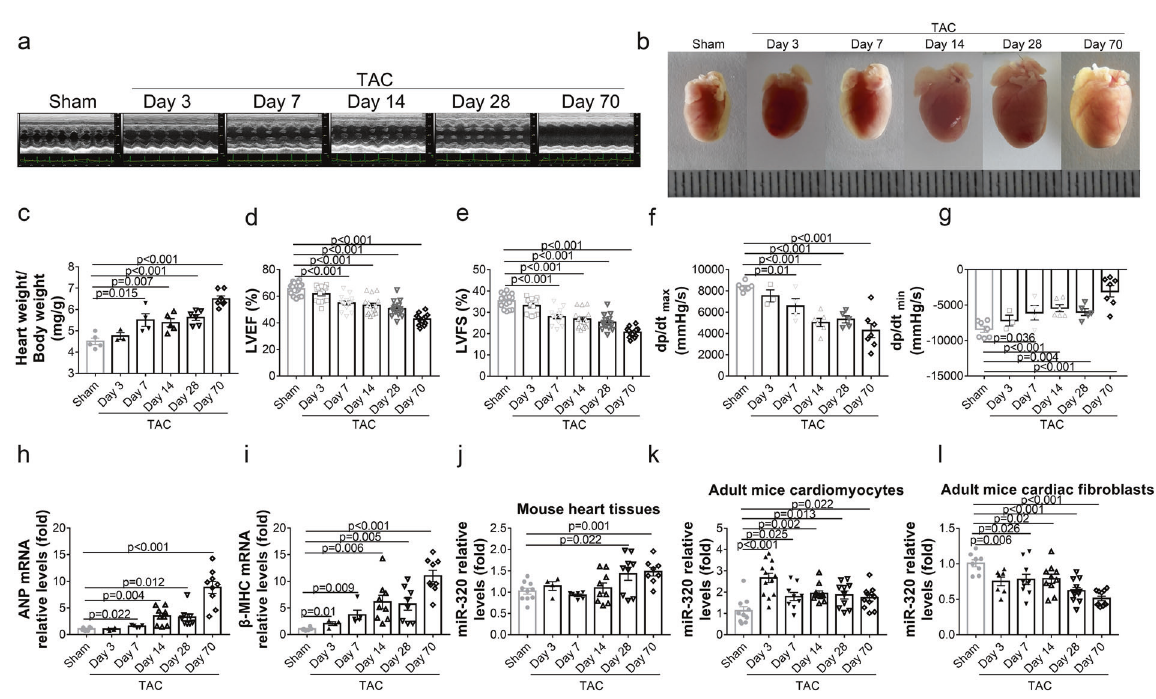
Fig. 2 MiR-320 expression patterns were opposite between isolated CMs and CFs from TAC mice. a C57BL/6 mice were killed to either sham operation ( n = 16) or TAC and noted after 3, 7, 14, 28, or 70 days ( n = 15, 15, 17, 14, or 13, respectively). Representative short axis images of echocardiograms. b Gross morphologies of hearts from mice after TAC at different time points are shown. c The ratios of heart weight and body weight in mice after TAC. d , e LVEF% and LVFS% were detected by echocardiography. f , g Hemodynamic parameters of mice with different treatments were measured by the Millar cardiac catheter system. dp/dt max , peak instantaneous rate of LV pressure increase; dp/dt min , peak instantaneous rate of LV pressure decrease. h , i ANP and β -MHC mRNA levels in the hearts were detected by real-time PCR. j MiR-320 expression levels in the hearts were quanti fi ed by real-time PCR. k The expressions of miR-320 in isolated CMs were measured by real-time PCR. l Real-time PCR analysis of miR-320 in isolated CFs. ANP Atrial natriuretic peptide, β -MHC β -myosin heavy chain, LVEF left ventricular ejection fraction, LVFS left ventricular fractional shortening; Data are presented as mean ±